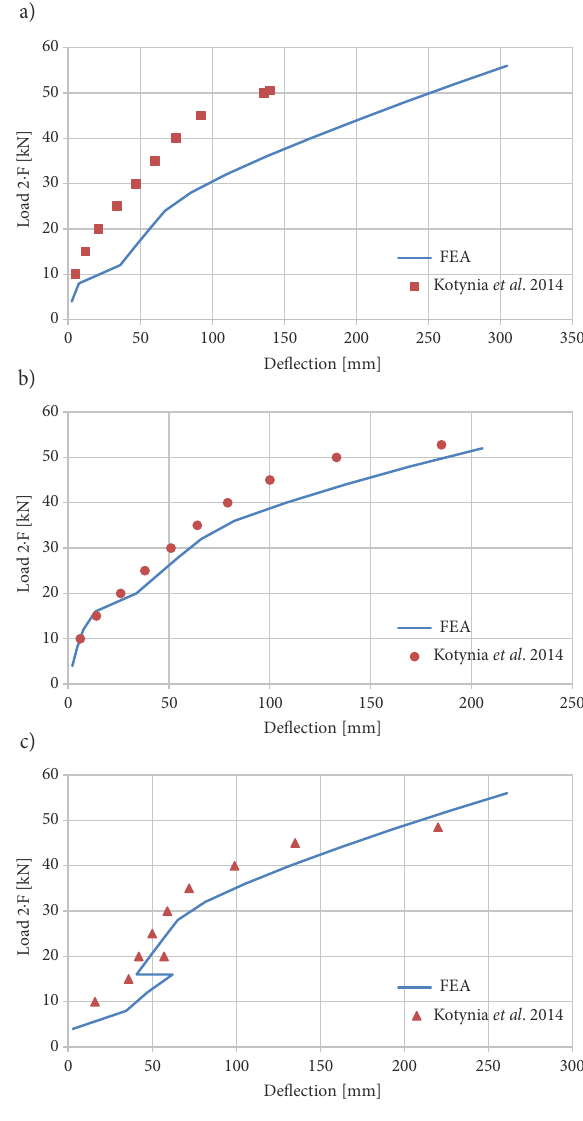
Fig. 6. External load vs deflection, curves predicted numerically and points from research. Reinforcement 4 ∅ 12: a – “a” series beams; b – “asp” series beams; c – “asp-e” series beams (Kotynia et al.